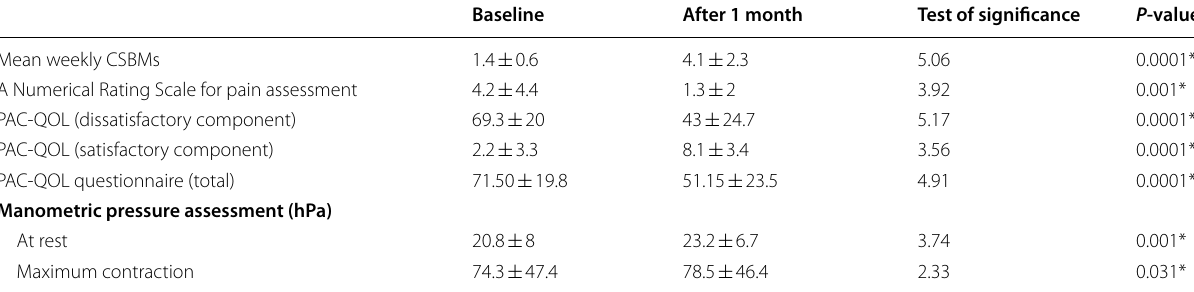
Table 2 Comparison of the outcome measures before and after the rehabilitation program in group 2 patients